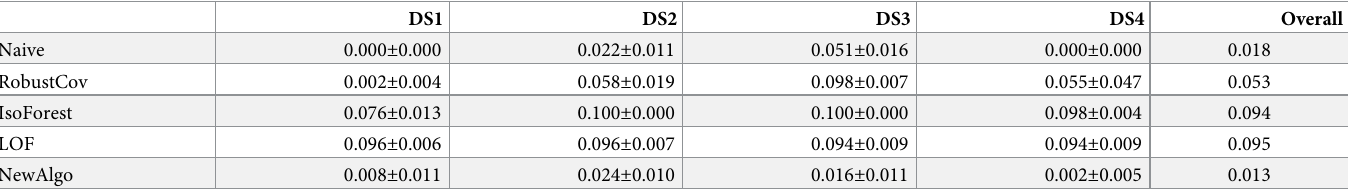
Table 3. The mean and standard deviation of FPR for the anomaly detection algorithms. The results represent experiments on four datasets based on 20 simulated experiments. DS1 DS2 DS3 DS4 Overall Naive